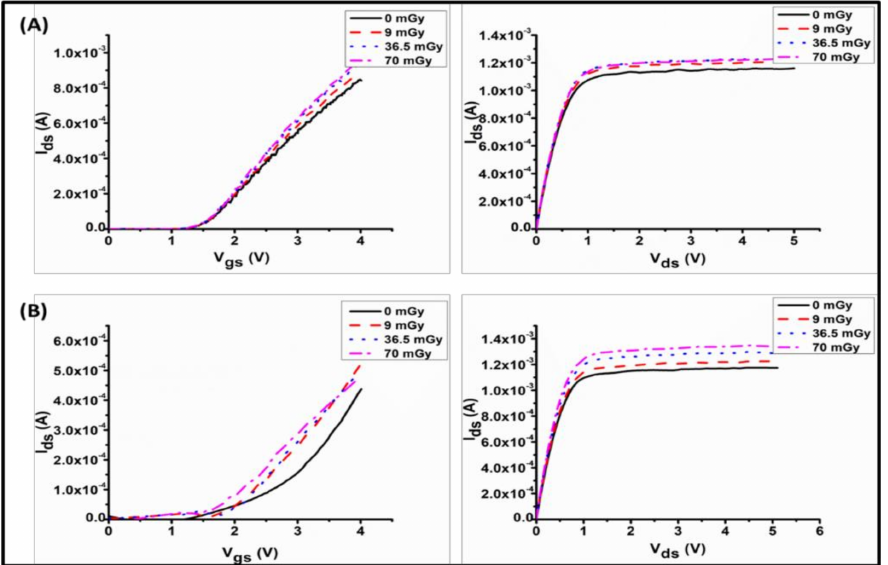
Figure 4. ( A ) Linear and saturation regime for the thin film and ( B ) linear and saturation regime for the 1 mm disk ZnO-Pb, under low absorbed